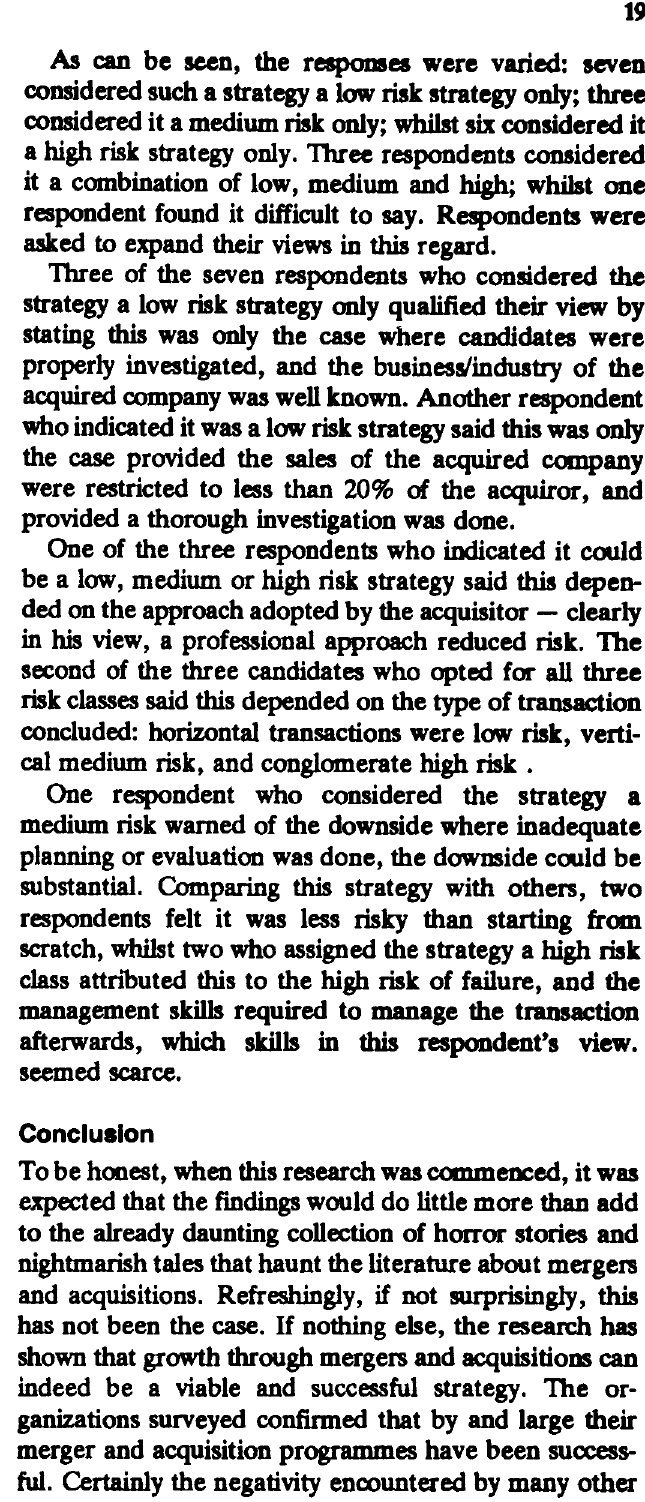
Table 5 Growth by mergers and acquisitions strategy: Risk classification